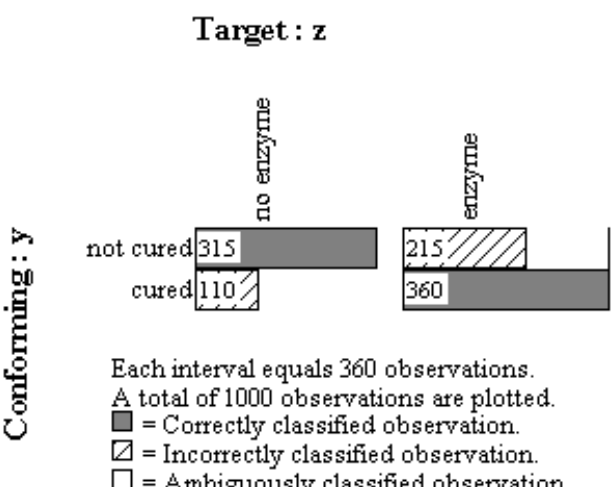
Figure 6. Multigram showing results conforming final effect (Y, cure) to mediating cause (Z,